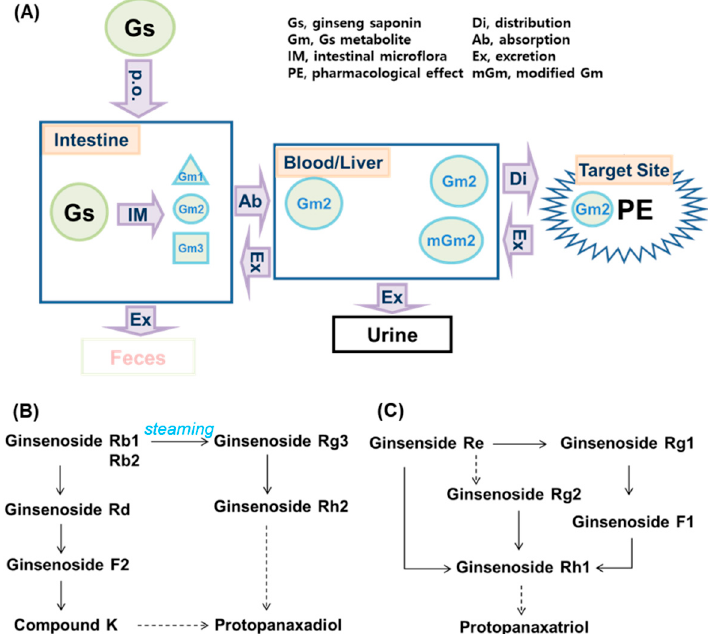
Figure 2. The proposed metabolic pathway of ginseng and its constituent ginsenosides by gut microbiota. ( A ) The fate of orally administered ginseng saponins in vivo. ( B ) The metabolic pathway of protopanaxadiol-type ginsenosides. ( C ) The metabolic pathway of protopanaxatriol-type ginsenosides. Solid arrows, potently proceeded; dashed arrows, weakly proceeded.